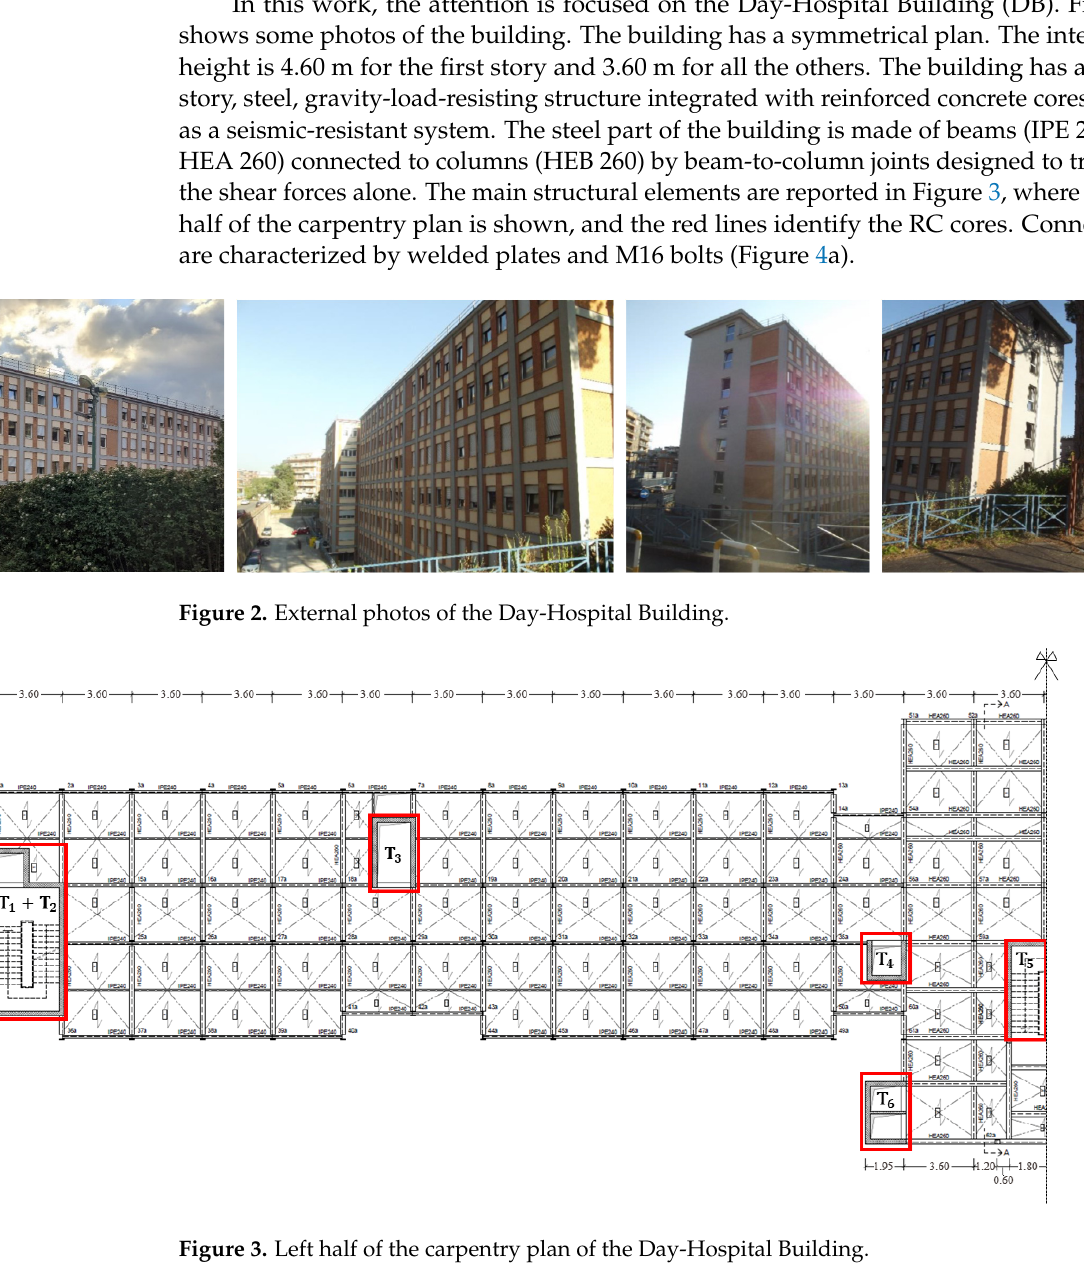
Table 1. Seismic performance indices for the DB building.